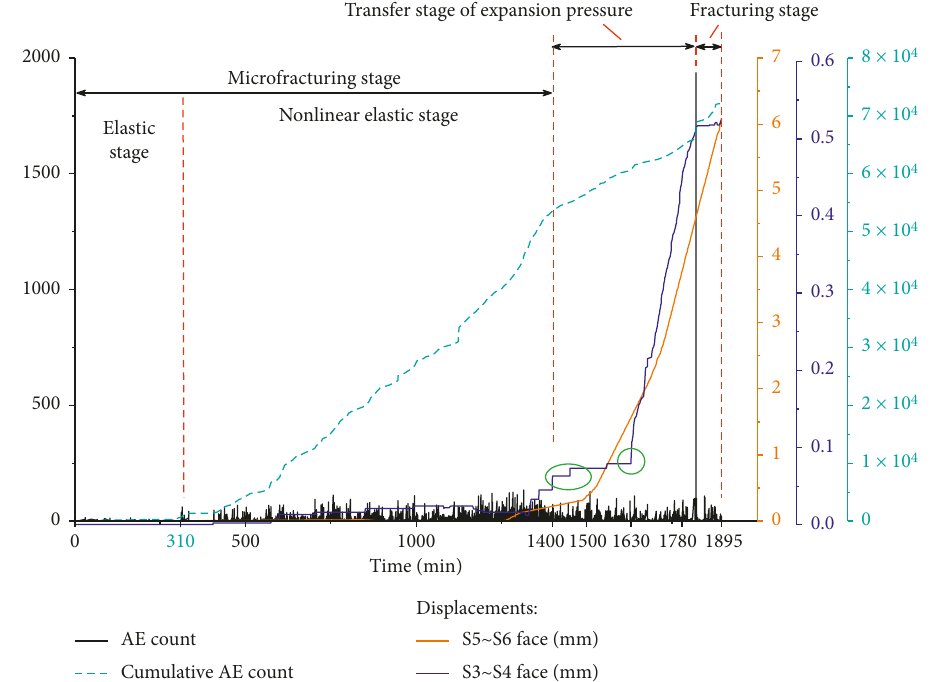
Figure 8: The relationships between displacement, AE event counts, cumulative AE event counts, and time before and after the fracturing of C40 concrete test